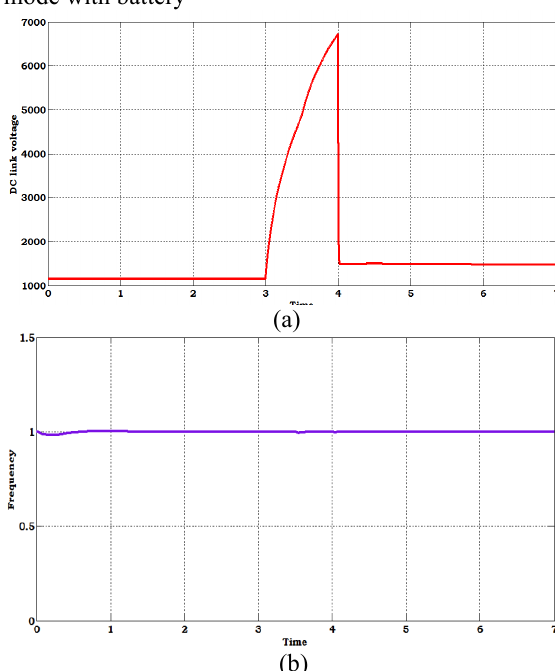
Figure 16. (a). DC link voltage, (b).Frequency Test Case 2: When operating system in grid connected mode with sudden disconnection of battery